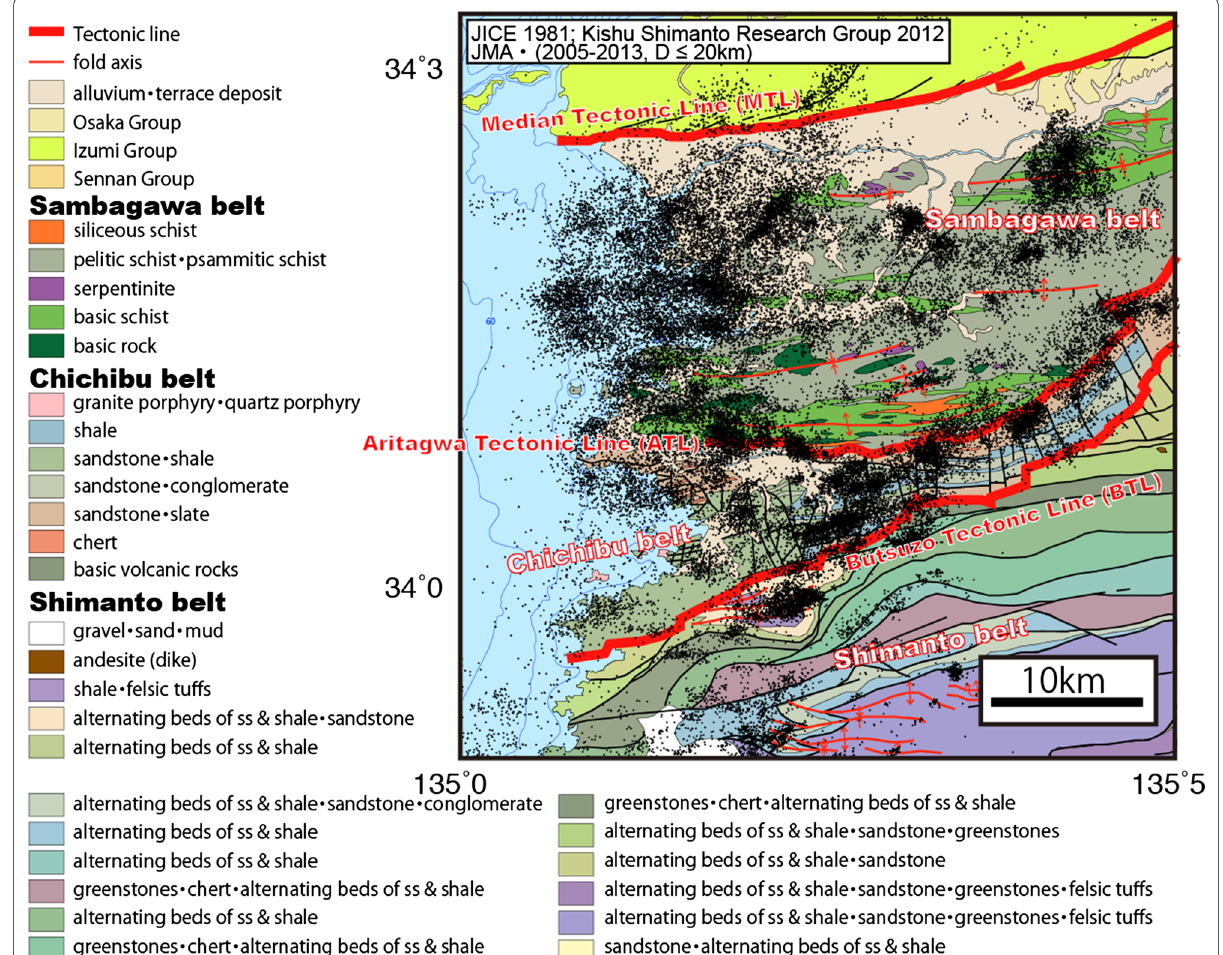
Fig. 2 Geological map and seismic activity in the study area. Geological information is from JICE (1981) and Kishu Shimanto Research Group (2012). Epicenter distribution for earthquakes shallower than or equal to 20 km in the period from 2005 to 2013 from the JMA catalog is shown by black